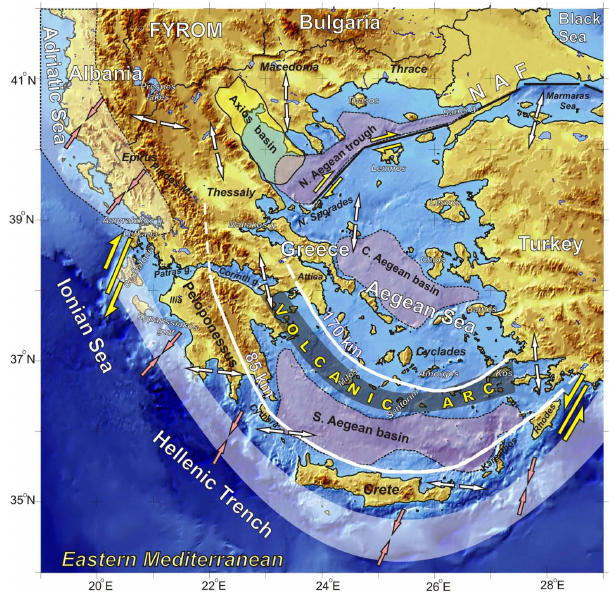
Figure 1. Main seismotectonic features of the study area (broader Aegean Sea region). Local stress field is depicted by open arrows, while the southern Aegean Benioff zone isodepths (white solid lines), the southern Aegean volcanic arc and major basins within the Aegean Sea are also presented (modified from Papazachos et al., 1998; Karagianni et al., 2005; Mountrakis et al.,